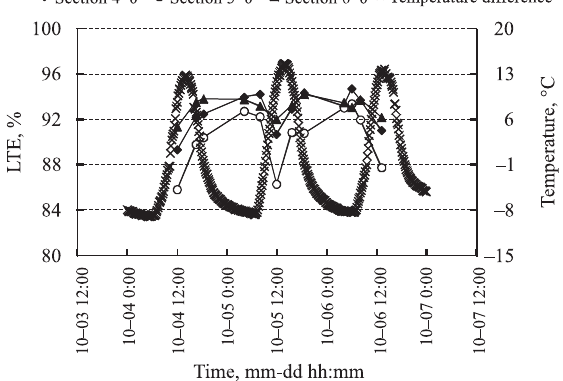
Fig. 2. Temperature data collected during test period